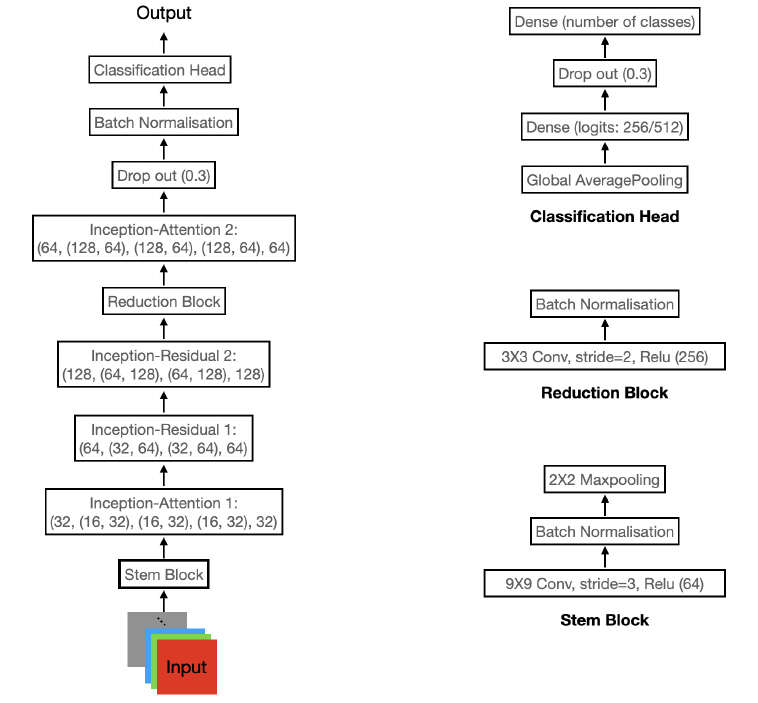
Figure 4. Structure of